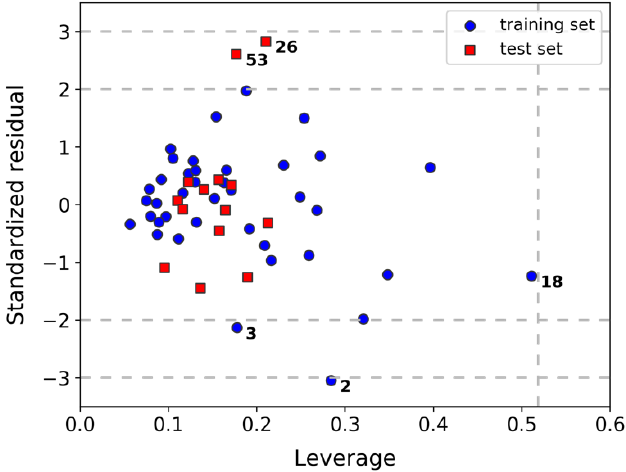
Figure 2. Williams plot for model K. Horizontal dashed lines represent 2 σ and 3 σ for the standardized residuals. Vertical dashed line represents h* .